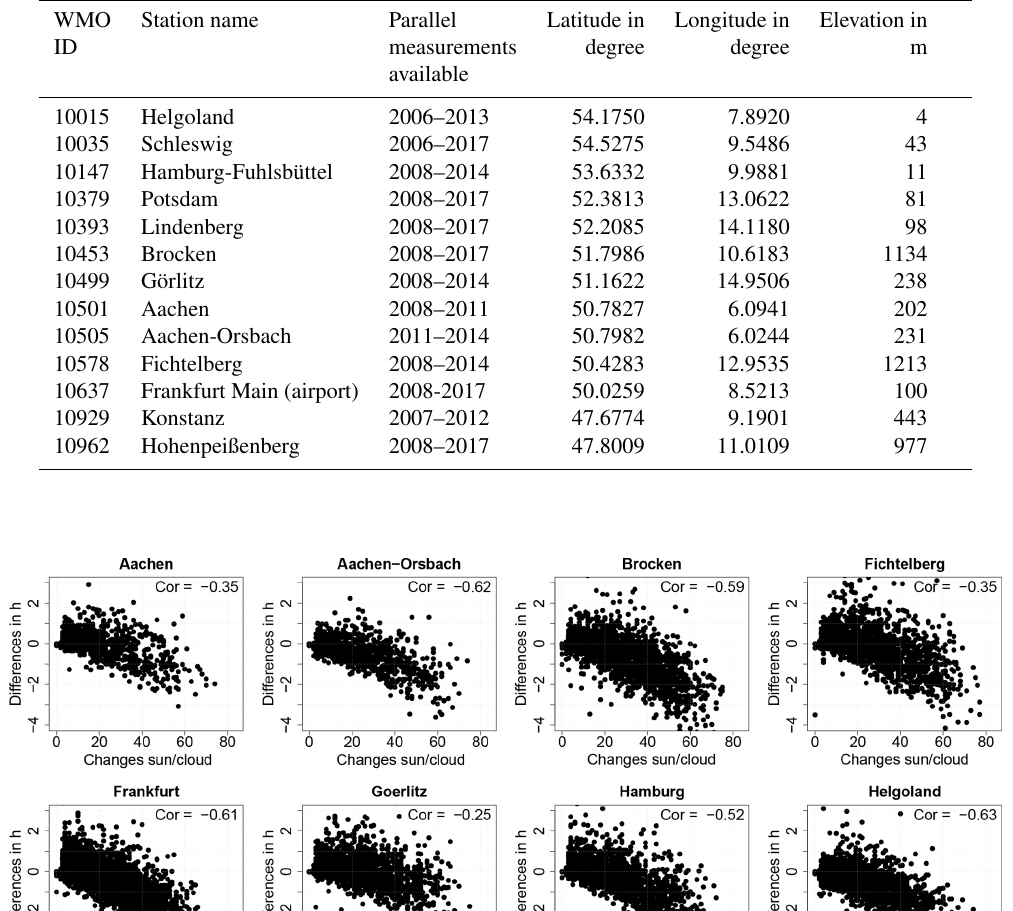
Table 1. Time range with parallel measurements; location and elevation (in meters) of each climate reference station.